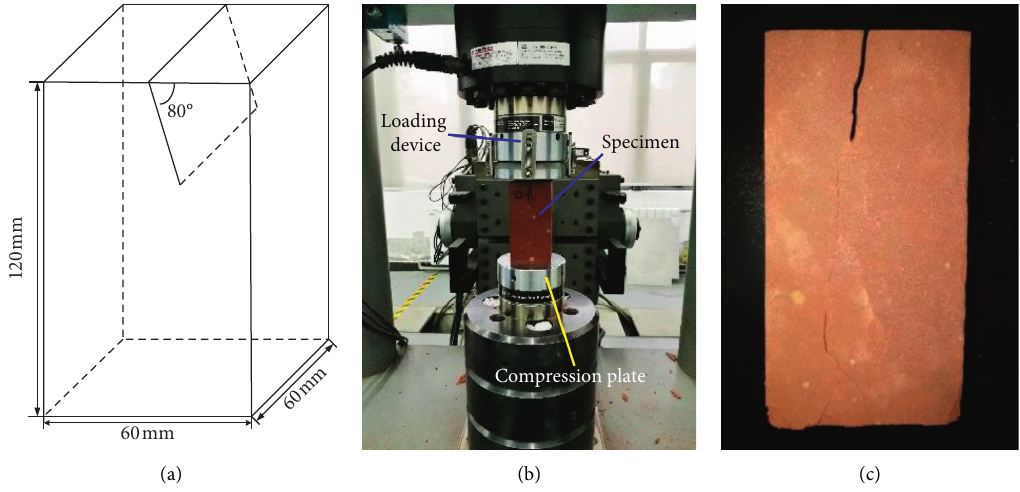
Figure 2: Rock specimens for uniaxial compression experiment. (a) Specimen size. (b) Before test. (c) After test.